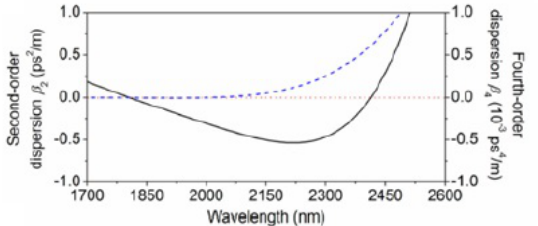
Fig. 14. The simulated second (black line) and fourth order (blue dashed line) dispersion of the 900 nm wide silicon waveguide. The sign of the second and fourth order dispersion are opposite in a band between 1810 and 2410 nm. Adapted from reference [63].